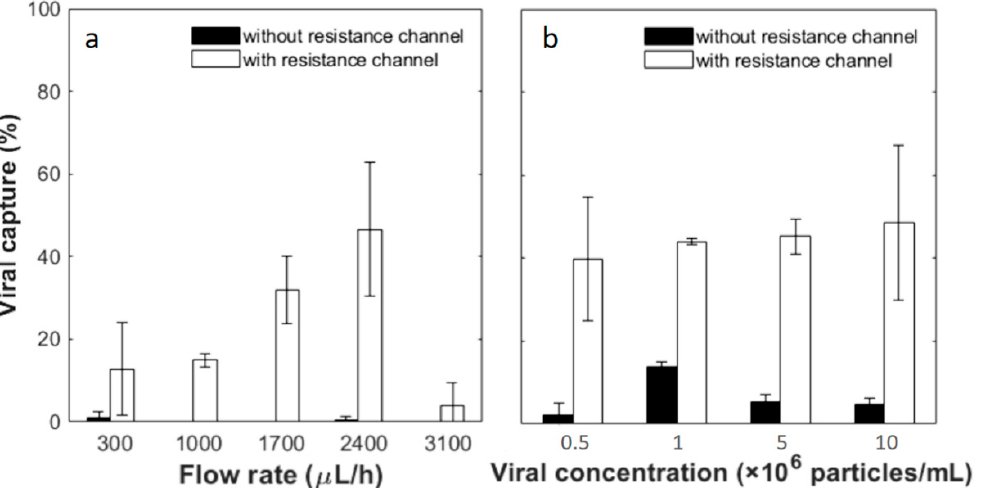
Figure 5. Viral capture yield as a function of ( a ) sample flow rates and ( b ) viral concentrations. Viral concentration used in ( a ) was 5 × 10 6 particles / mL. The flow rate applied in ( b ) was 2400 µ L / h. The white bars are results from filtration devices connected with the 65 mm resistance channel, while black bars are results from devices without. Error bars represent the standard deviation from at least 3 devices under the same conditions. Statistical analysis was conducted for ( b ) by applying an independent Student’s t-test at a 95% confidence interval and no statistically significant di ff erence is observed among the white bars.